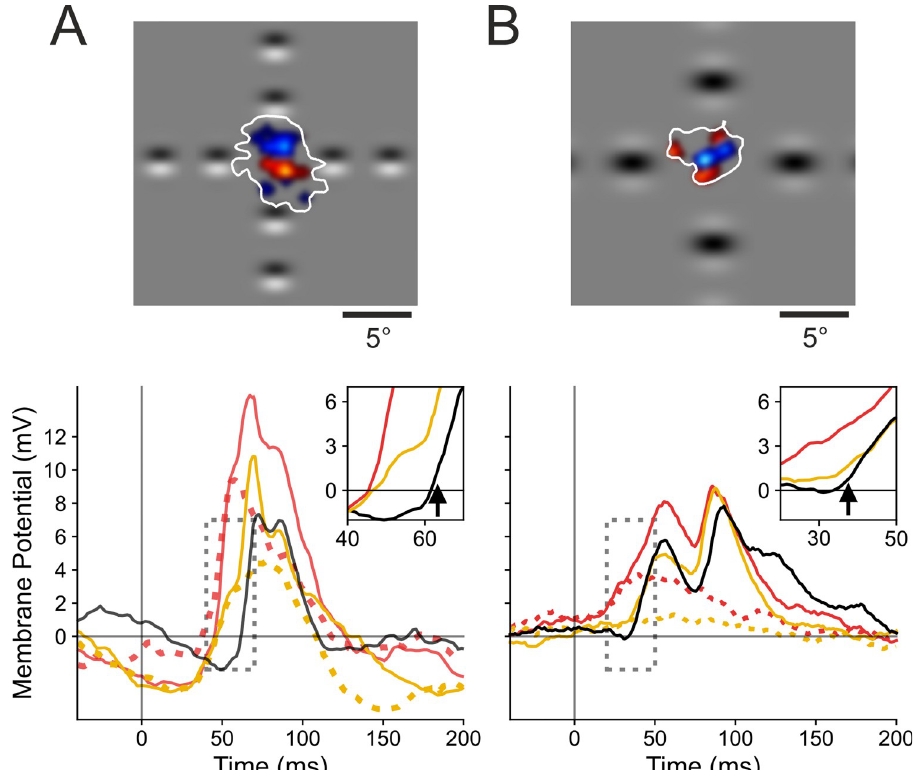
Fig 5. Differential recruitment of “Near” vs “Far” Surround between the “cardinal” vs . “radial” protocols. (A): “cardinal” protocol (left panel), and (B): “radial” protocol (right panel). Top row, receptive field maps. Same convention as in Fig 3A. Only the Surround GPs on the RF main (horizontal) and width (vertical) axis (common to both protocols) are represented within the same viewing field (20˚x20˚). Note the encroachment of the most proximal GPs in the “cardinal” protocol over the SRF (white contour), whereas no spatial overlap is seen in the “radial” protocol. Bottom rows, the CP-ISO (red) and CP-CROSS (gold waveforms) are overlaid for the “Surround-Only” (dotted) and the “Surround-then-Center” (continuous trace) conditions and compared to the “Center-Only” test condition (black). Insets show respectively an expanded version of the PSPs onset on a 30 ms time window (dotted grey rectangle). For each protocol, arrows indicate the change in PSP slope due to the feedforward synaptic drive triggered by the Center test stimulus in the D0 location. Note that the CP-ISO and CP-CROSS (gold) response latencies are the same for the “cardinal” protocol, suggestive of a common non-specific input. In contrast, the phase advance is seen only for the CP-ISO configuration in the “radial” protocol. See Text for details. RF center (Surround-then-Center, continuous traces). The top row in Fig 5 illustrates the RF maps of the spiking discharge fields (ON (red) and OFF (blue)) and of the subthreshold SRF (topological union of ON and OFF depolarizing receptive fields) delimited by a white contour. In order to focus the comparison on the stimulation axes used in the “cardinal” protocol, we illustrate, for the “radial” protocol cell (5B, right panel), only the CP-ISO and CP-CROSS Sec- tor AM configurations (first and third row, in the left column of Fig 1C, red and gold schemes) along respectively the RF main and width axes. A straightforward observation directly emerges from the comparison of the visual field paving with Surround GPs applied in each protocol: for the same spatial viewing field size centered on each RF (20˚x20˚), the two Surround sources of stimulation are visible for the “cardinal” protocol, while only one—the most proximal (to the RF center)—appears for the “radial” protocol. The closest GP location in the periphery (D1 position in Fig 1A) partially encroaches on the border of the SRF in the “cardinal” protocol, while this is not the case (by design) for any surround sources in the “radial” protocol.